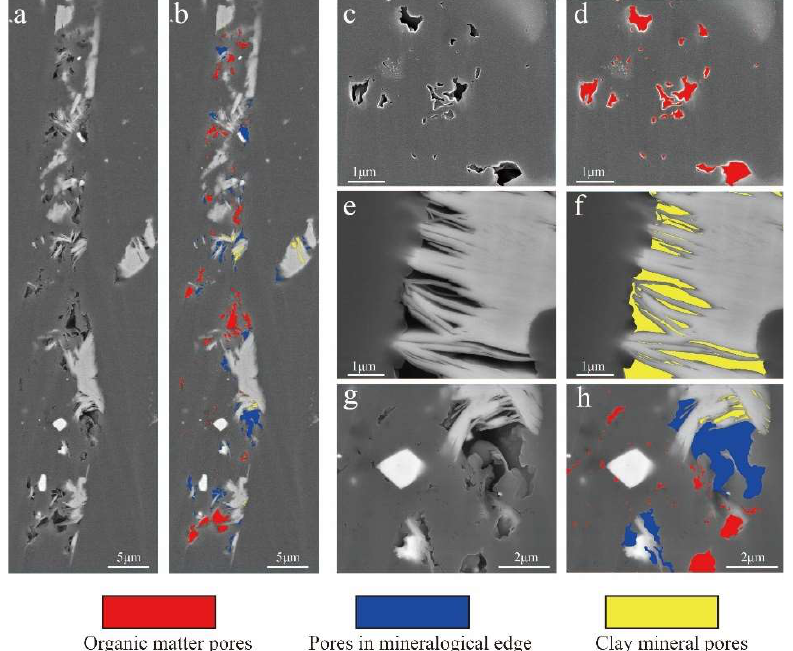
Figure 2. Field emission scanning electron microscope (FESEM) images ( a , c , e , g ) and image processing of the representative porous areas at nanoscale showing the coexistence of organic matter pores, pores in the mineralogical edge, and clay mineral pores ( b , h ), as well as typical organic matter pores ( d ) and clay mineral pores ( f ).